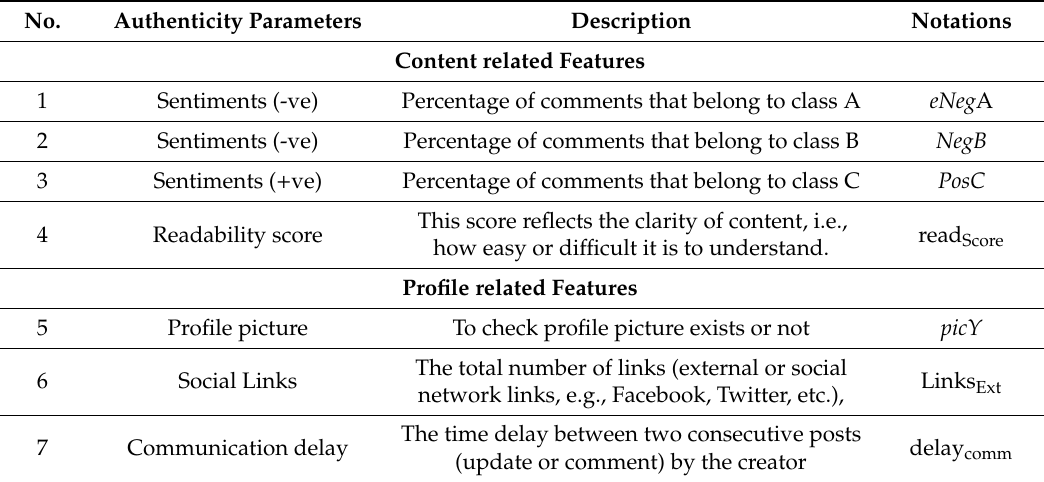
Table 4. Definitions of the parameters of